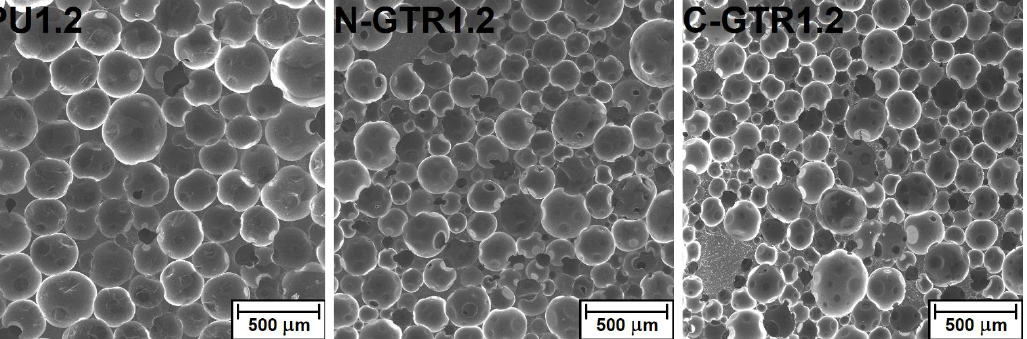
Figure 1. SEM images showing the cellular structure of prepared PU foams and PU/GTR compo- sites. Table 2. Parameters of cellular structure and thermal conductivity coefficients for prepared PU foams and PU/GTR composites.